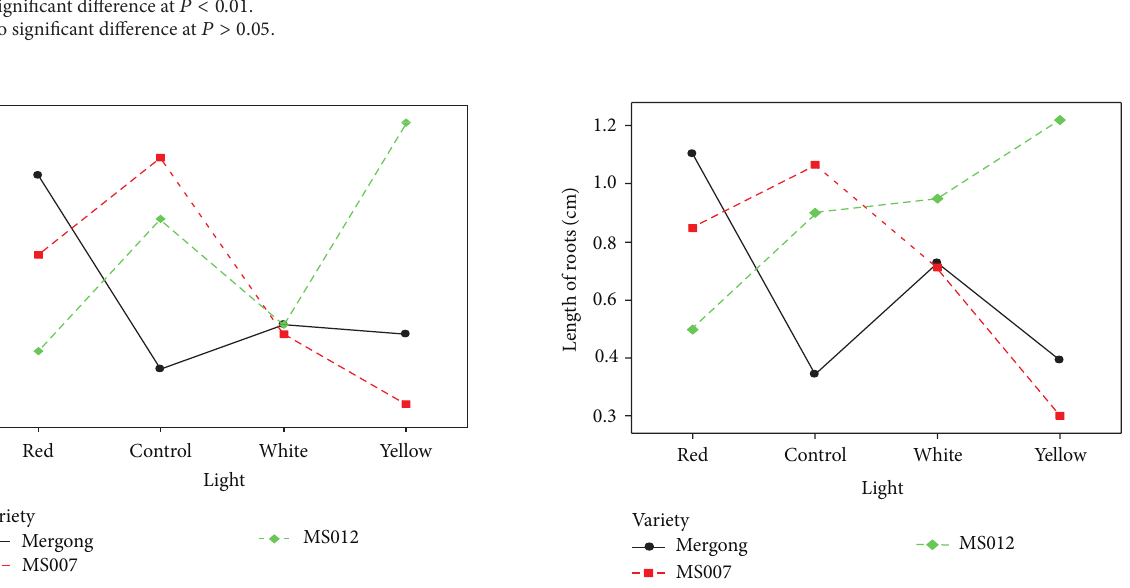
Figure 1: Interactions between varieties and light treatments in root number on day 14.